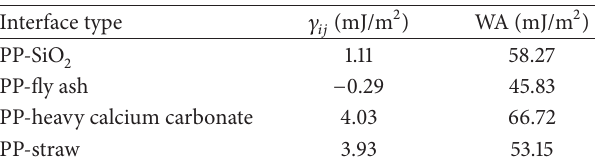
Table 2: Calculated interfacial energy and thermodynamical work of